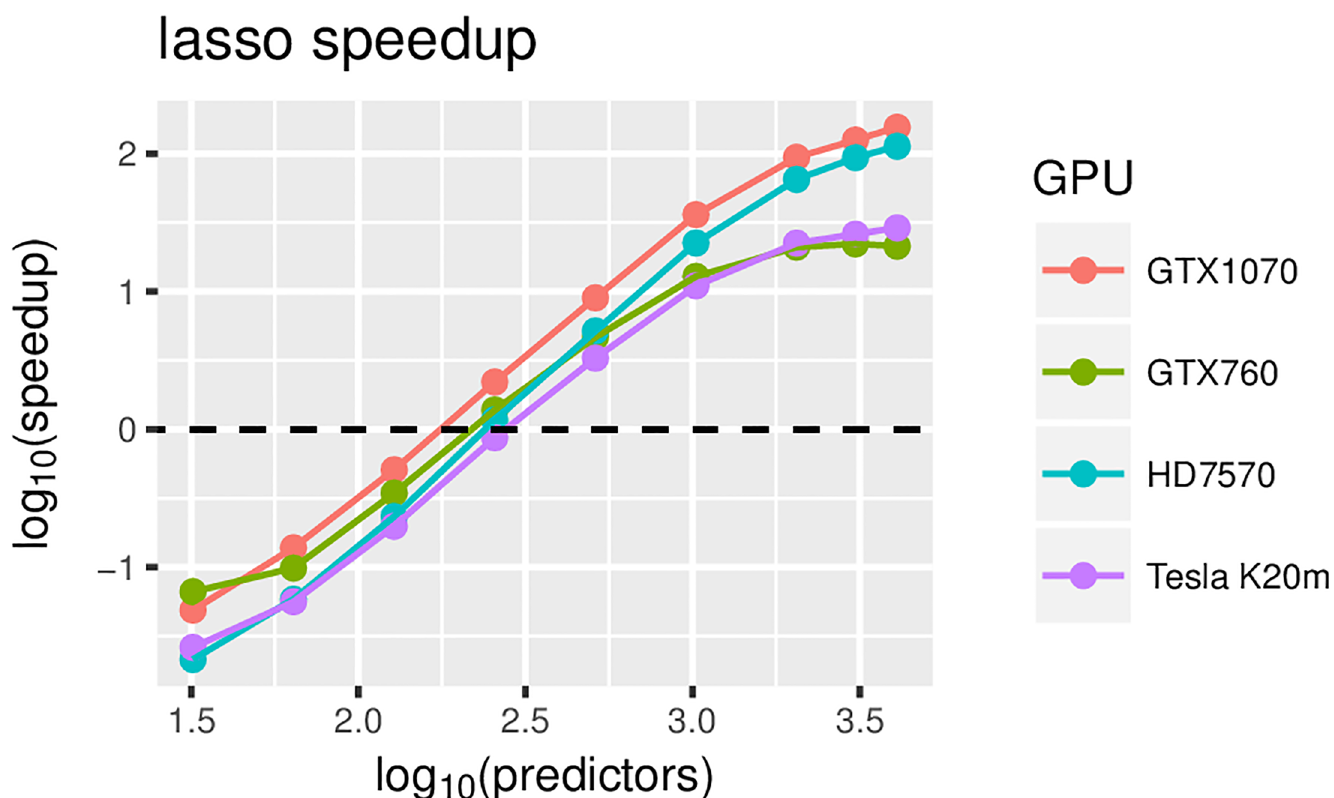
Fig 4. Lasso speedup relative to CPU-only version (on Intel i5-6600K@ 3.50 GHz) for different GPUs and an increasing number of predictors.